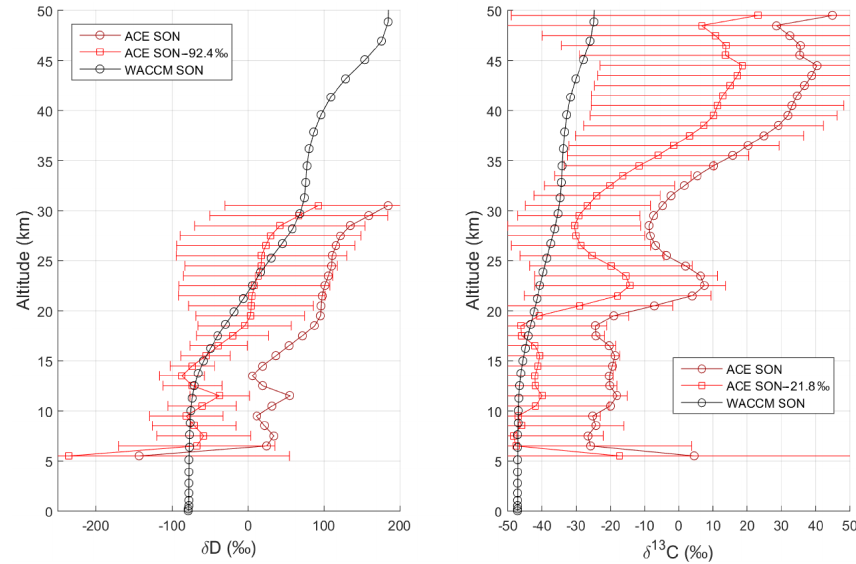
Figure 12. Results of ACE calibration compared to WACCM. Data shown here are from the 60 ◦ S September/October/November data bin. The error bars on the calibrated ACE data are equal to 1 standard deviation of the measurements at that altitude.